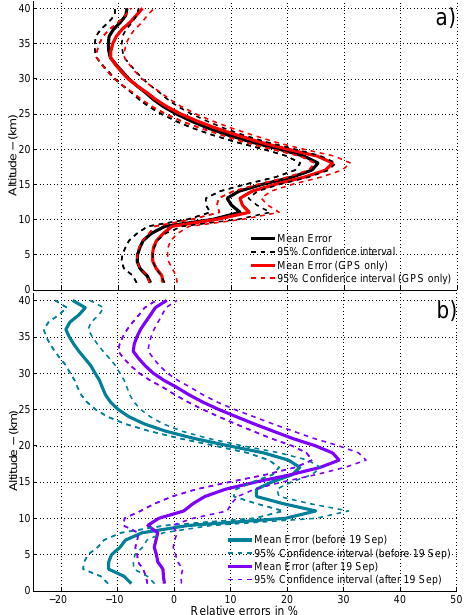
Fig. 6. (a) The average relative difference computed between IASI and radiosonde ozone profile measurements. It is the average of 20 comparisons, where the relative error is calculated as the difference between IASI profile and the smoothed balloon profile divided by the smoothed profile at each altitude. Black lines represent the mean and confidence interval of overall comparisons, whereas red lines take into account only comparisons of GPS-equipped ozonesondes. (b) Blue lines represent the comparisons of profiles observed before 19 September, whereas violet lines represent profiles observed after 19 September (when ozone loss was clearly observed in the mixing ratio